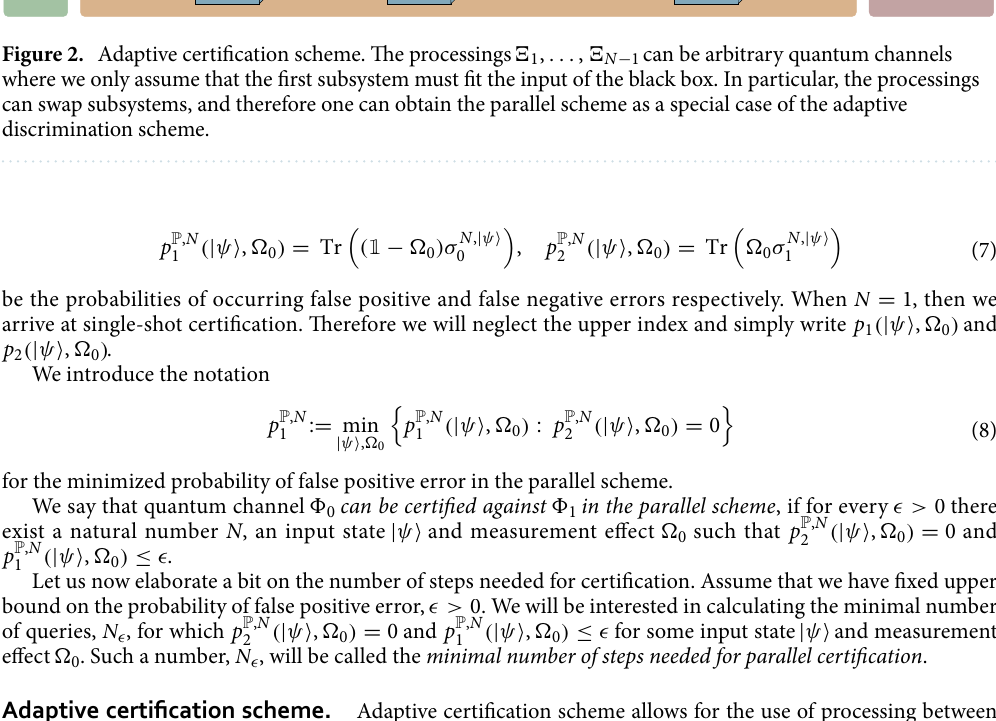
1 can be arbitrary quantum channels −